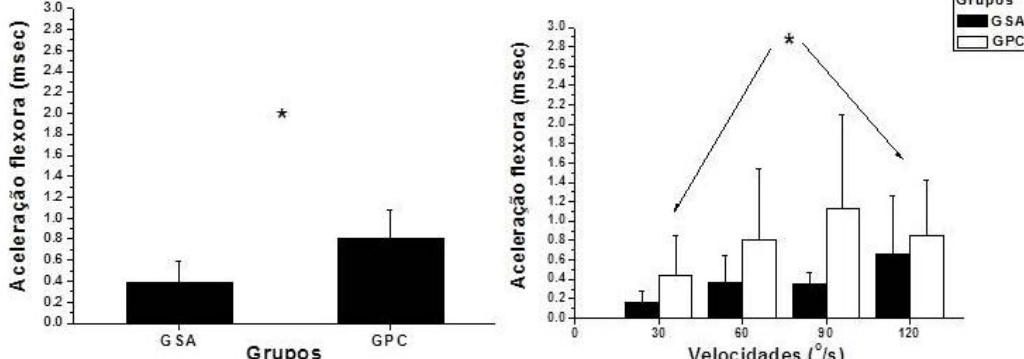
Figura 5. Média e desvio padrão da aceleração flexora nos grupos GSA e GPC e média e desvio padrão da aceleração 30, 60, 90 e 120°/s. * diferença estatisticamente significante entre grupos e velocidades 30 e